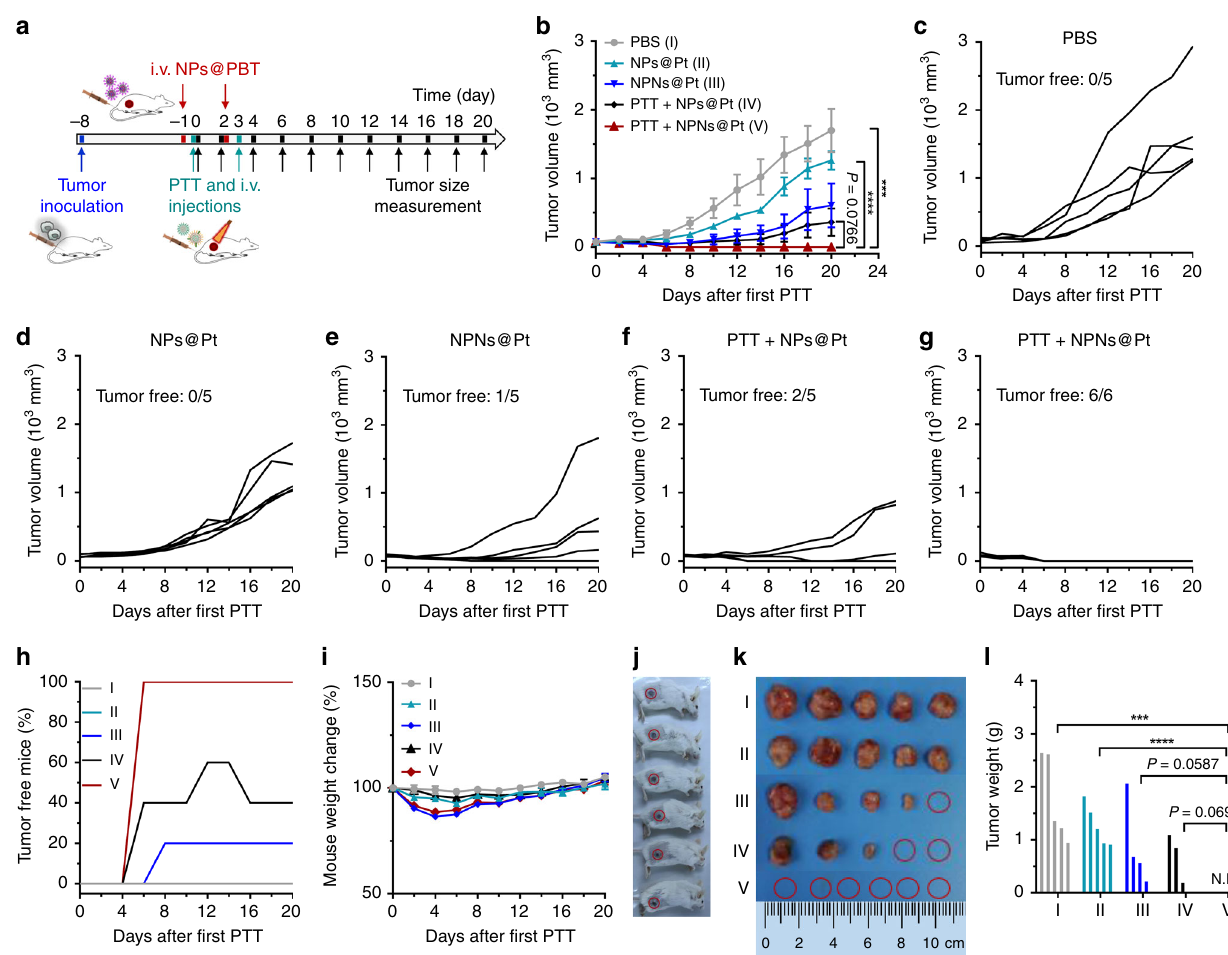
Fig. 8 Two treatments of PTT plus NPNs@Pt completely eradicated tumors in all mice. a Work fl ow for treatment of EMT6-bearing mice using PTT- based neutrophil-mediated NPNs@Pt delivery system. On day -1 and day 2 (de fi ned as the 7th and 10th day after tumor inoculation, respectively), mice were i.v . injected with NPs@PBT. On days 0 and 3, the mice received PTT treatment on the tumors followed by an i.v . injection of PBS, NPs@Pt, or NPNs@Pt. Tumor volumes were measured every two days from day 0 to day 20. n = 6 for PTT + NPNs@Pt, and n = 5 for the other groups. b Tumor growth curves during the treatments. c – g Growth of individual tumors during the treatments. h The percentage of tumor-free mice during the treatments. i Change of mouse weight during the treatments. j Photos of mice treated with PTT + NPNs@Pt on day 20, which showed complete eradication of the EMT6 tumors in all six mice. k Photos and l weight of the tumors collected on day 20. Data are shown as mean ± SEM and analyzed by unpaired